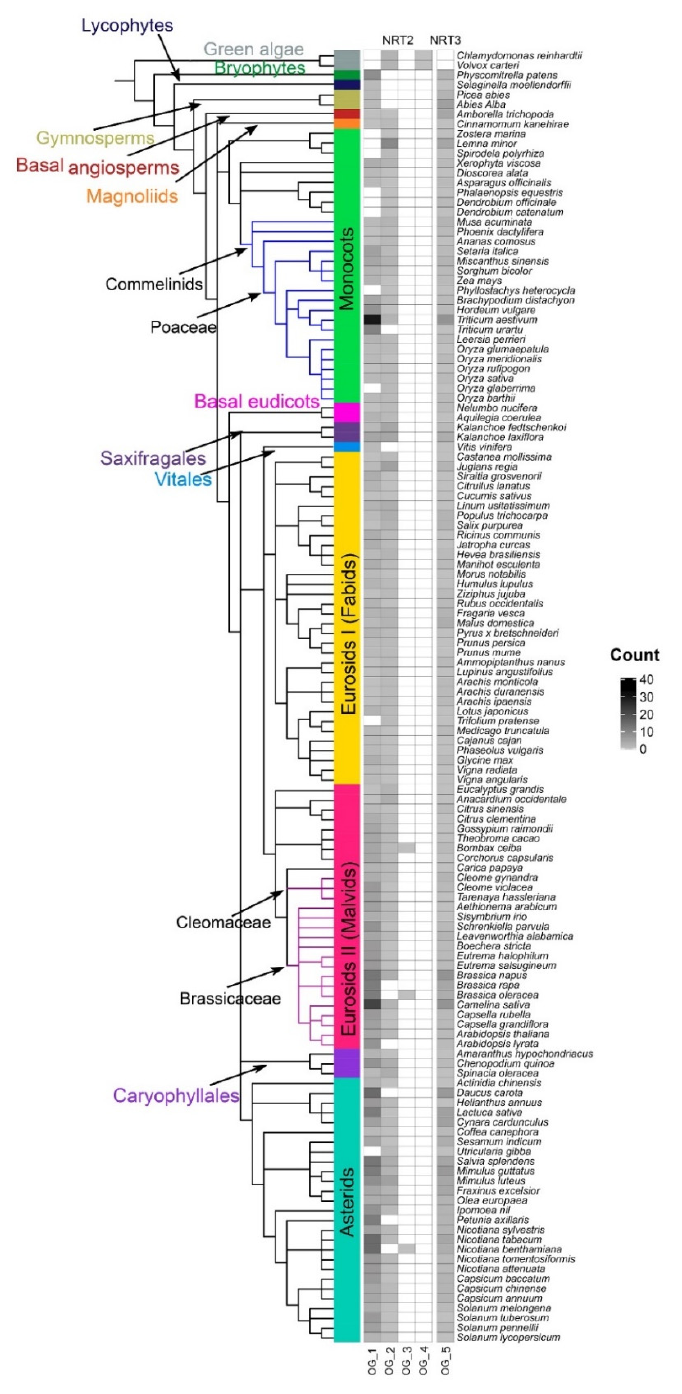
Figure 7. Heat map of orthologous groups (OG). Phylogenetic profile of the assigned OG within the NRT2 and NRT3 families in the 132 plant species studied. The color of the boxes indicates the number of sequences that make up an orthogroup in each species.